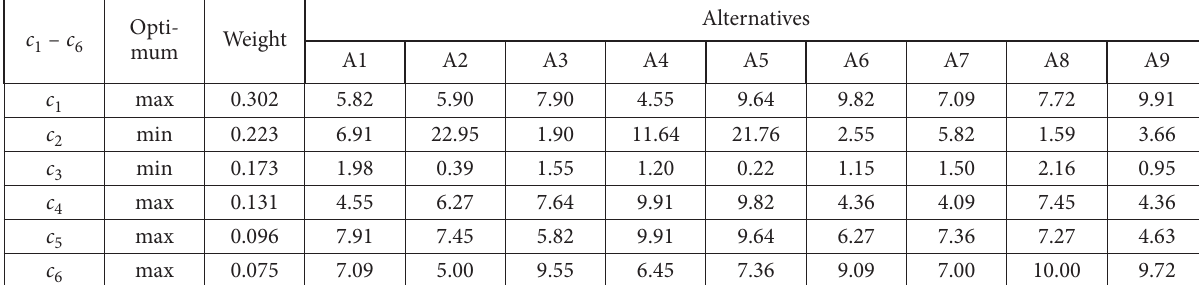
Table 5. Criteria and alternatives to weight ratio